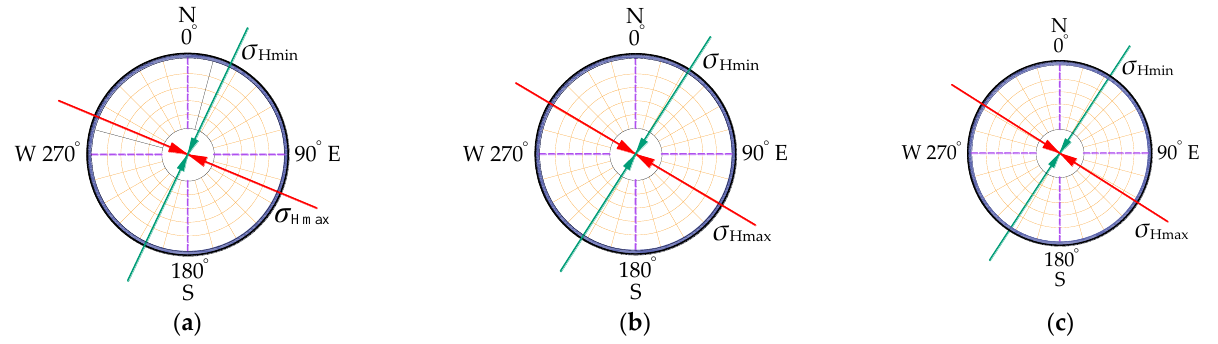
Figure 3. Azimuths of horizontal principal stresses at different stations: ( a ) G1 station; ( b ) G2 station; ( c ) G3 station.